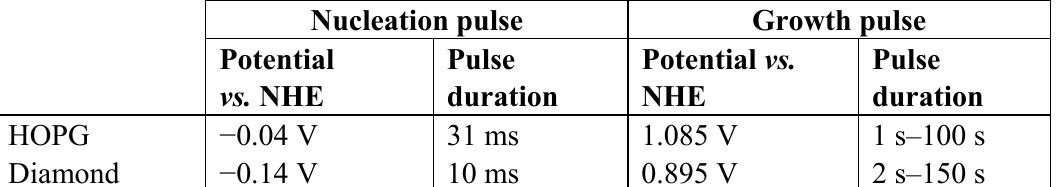
Table 2. Parameters for double pulse deposition of gold on HOPG and